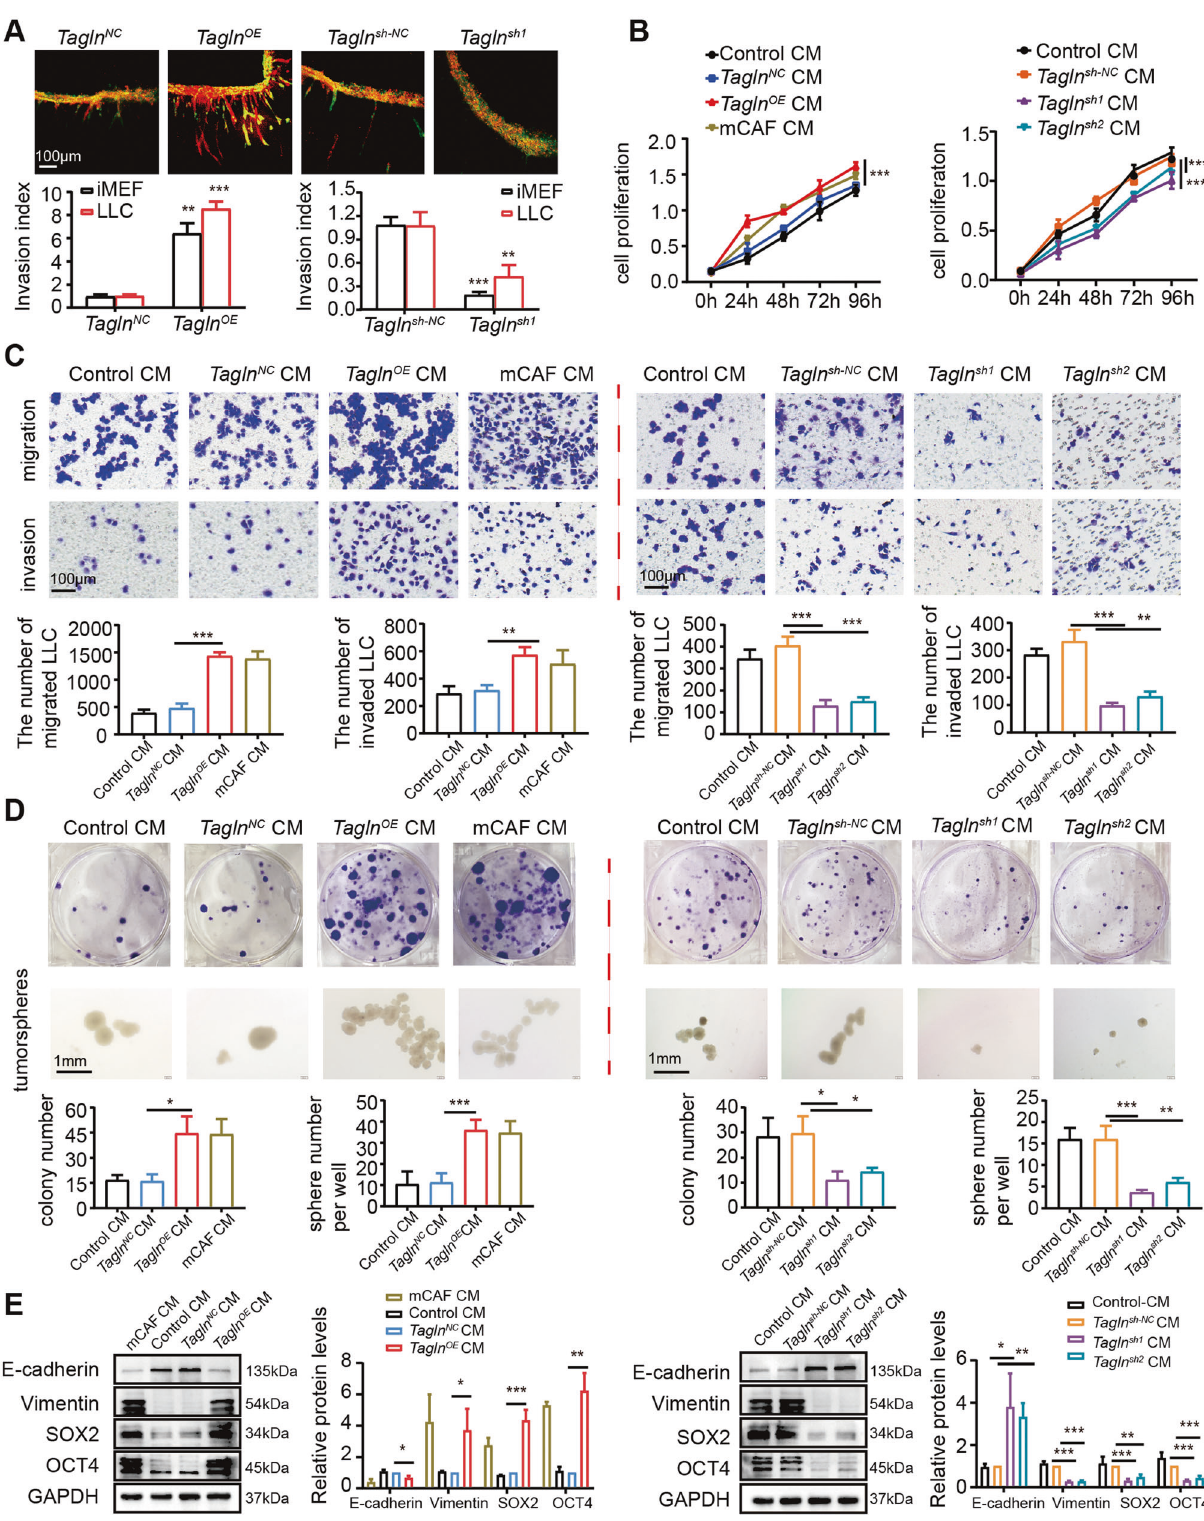
Fig. 4 Tagln OE fi broblasts promote cell migration, invasion, and cancer cell stemness in lung cancer cells. A Immortalized mouse embryonic fi broblasts (iMEFs; green) and Lewis lung cancer cells (LLCs; red) were subjected to a 3D gel invasion assay. Scale bar: 100 µm. B Effect of Tagln overexpression or knockdown on LLCs proliferation. C Effects of conditioned medium (CM) derived from Tagln OE iMEFs or Tagln sh iMEFs on LLC migration and invasion. Scale bar: 100 µm. D Colony formation by LLCs with CM from T Tagln OE iMEFs or Tagln sh iMEFs. The sphere numbers of LLCs were counted by ImageJ software. Scale bar: 1 mm. E Western blot analysis of epithelial – mesenchymal transition- related proteins and cancer stem cell markers in LLCs with different CM. Data are represented as mean ± SEM from at least three independent experiments. *** p < 0.001; ** p < 0.01; * p <